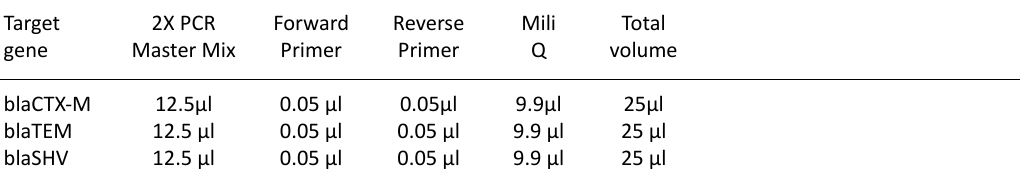
table 2. PCR Reaction mixture for β-lactamase genes